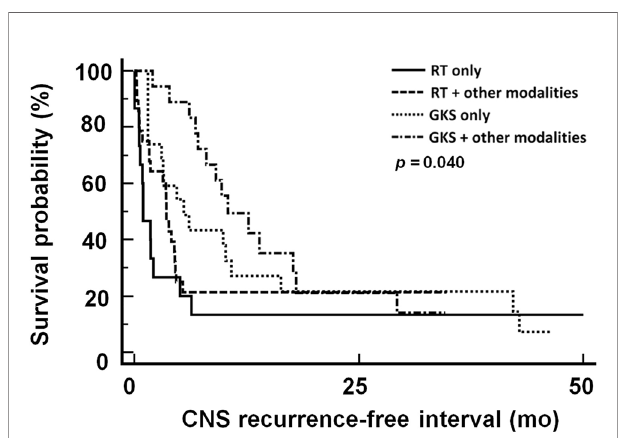
FIGURE 3 | CNS recurrence-free interval in patients treated with different treatment modalities. CNS, central nervous system; RT, radiation therapy; GKS, gamma knife radiosurgery. RT included WBRT and spinal RT.